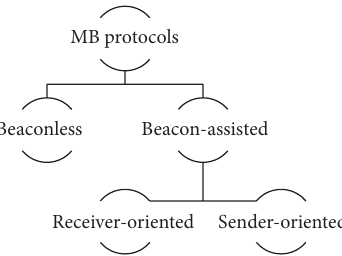
Figure 1: A classification of multihop broadcast protocols for